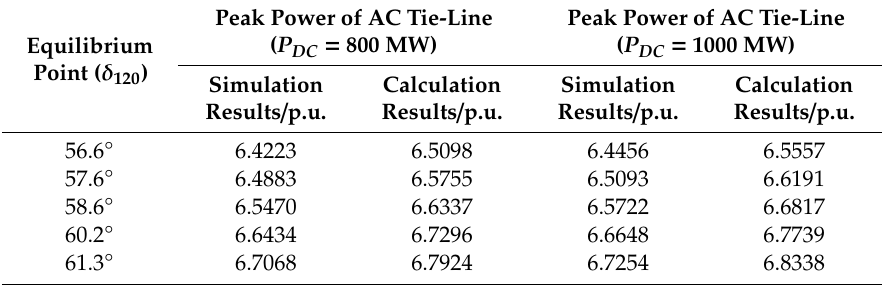
Figure 6. Power oscillations of the AC tie-line at di ff erent stable operating power angles ( P DC = 8 p.u.). Table 2. Simulation and calculation results of the peak power oscillations of the AC